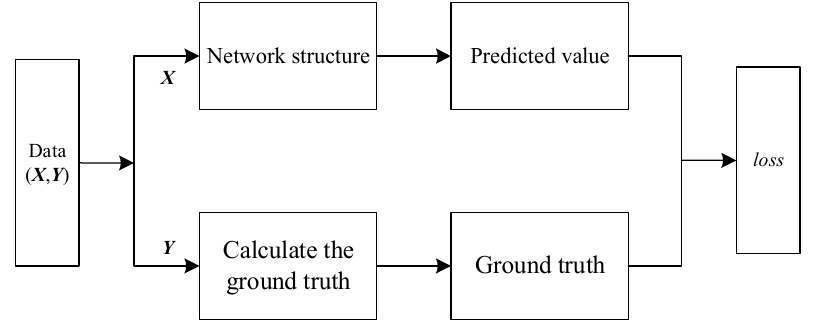
Figure 6. A flow chart of object detection.